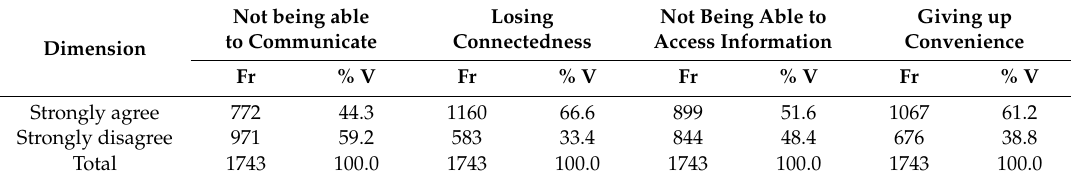
Table 5. Percentage agreeing or disagreeing with the corresponding